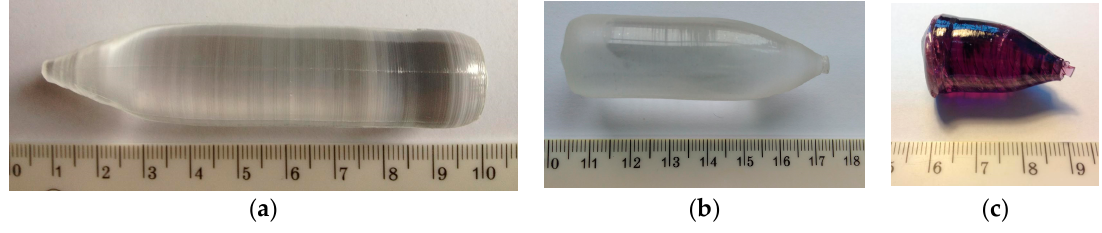
Figure 1. ( a ) Ca 3 Y 2 (BO 3 ) 4 crystal grown in argon from Ir crucible; ( b ) Ca 3 Gd 2 (BO 3 ) 4 crystal grown